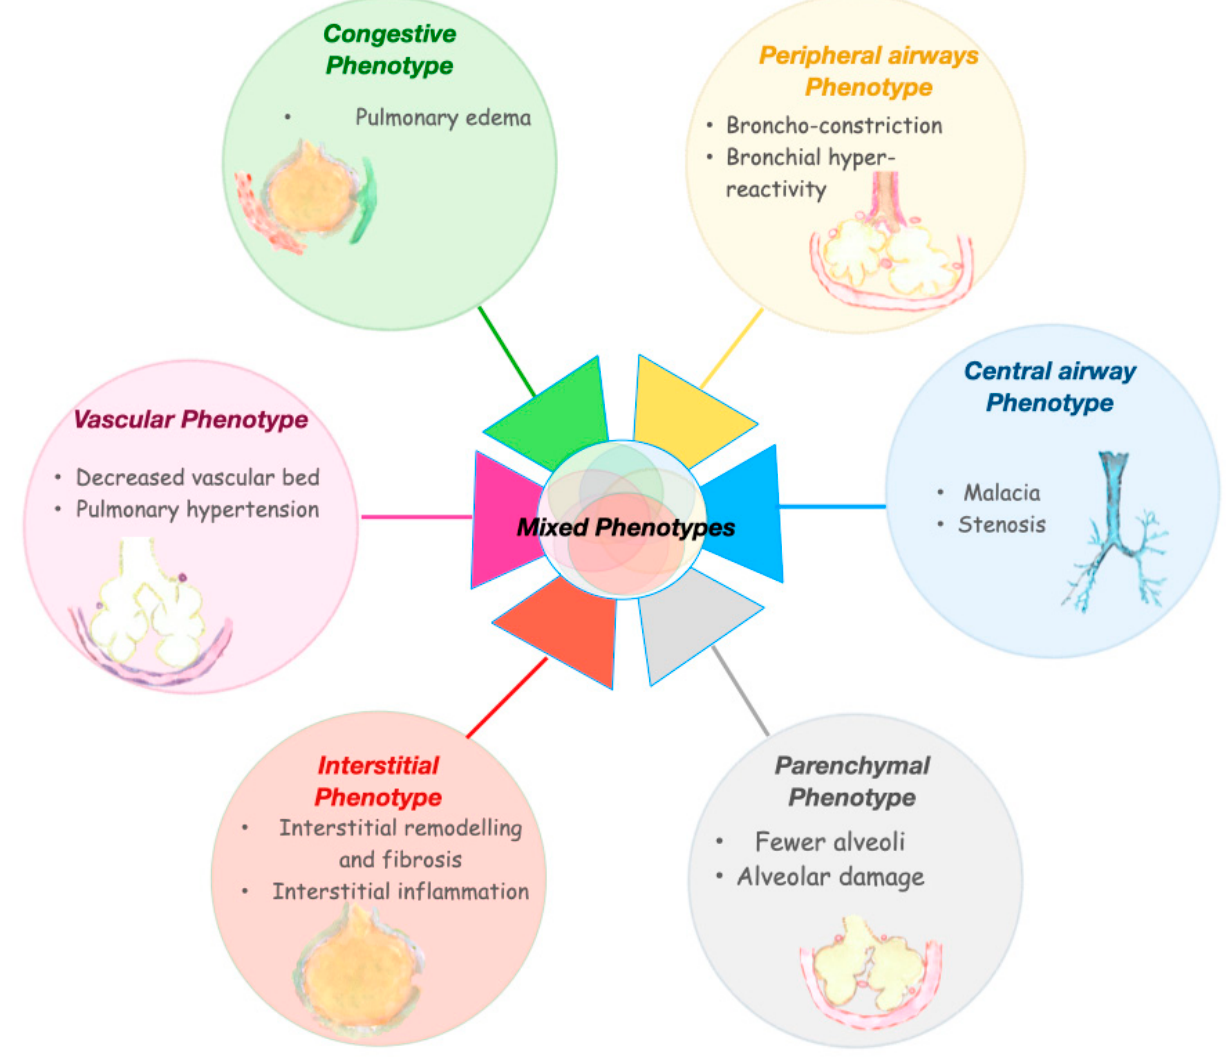
Figure 4. Bronchopulmonary dysplasia phenotypes.